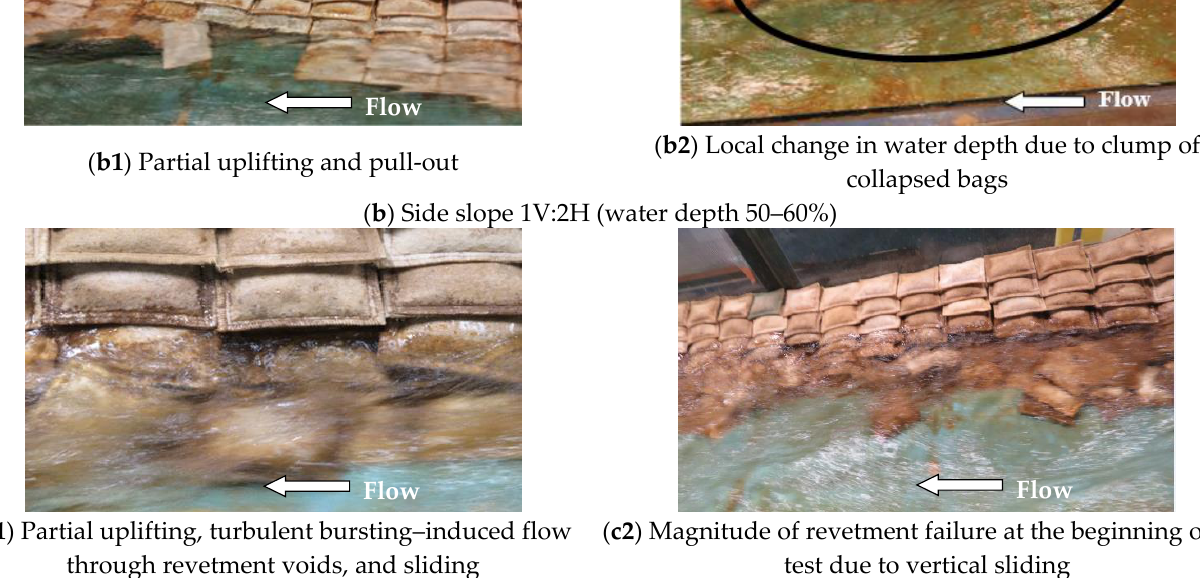
Figure 8. Failure processes in geobag revetment for stack bond.